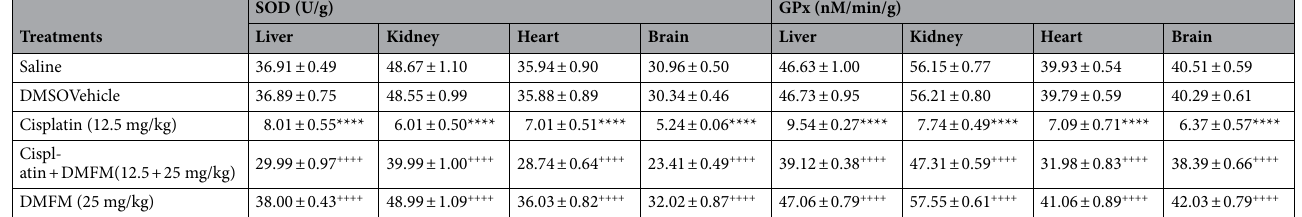
Table 4. Effect of treatment with MMINA on antioxidant parameters in cisplatin-treated rat organs. Data are mean ± SEM, (n = 7). *, **** p < 0.05 and P < 0.0001 versus Control respectively, and ++++ P < 0.0001 versus CP. Data analyzed by One-way ANOVA followed by Tukey’s multiple comparison